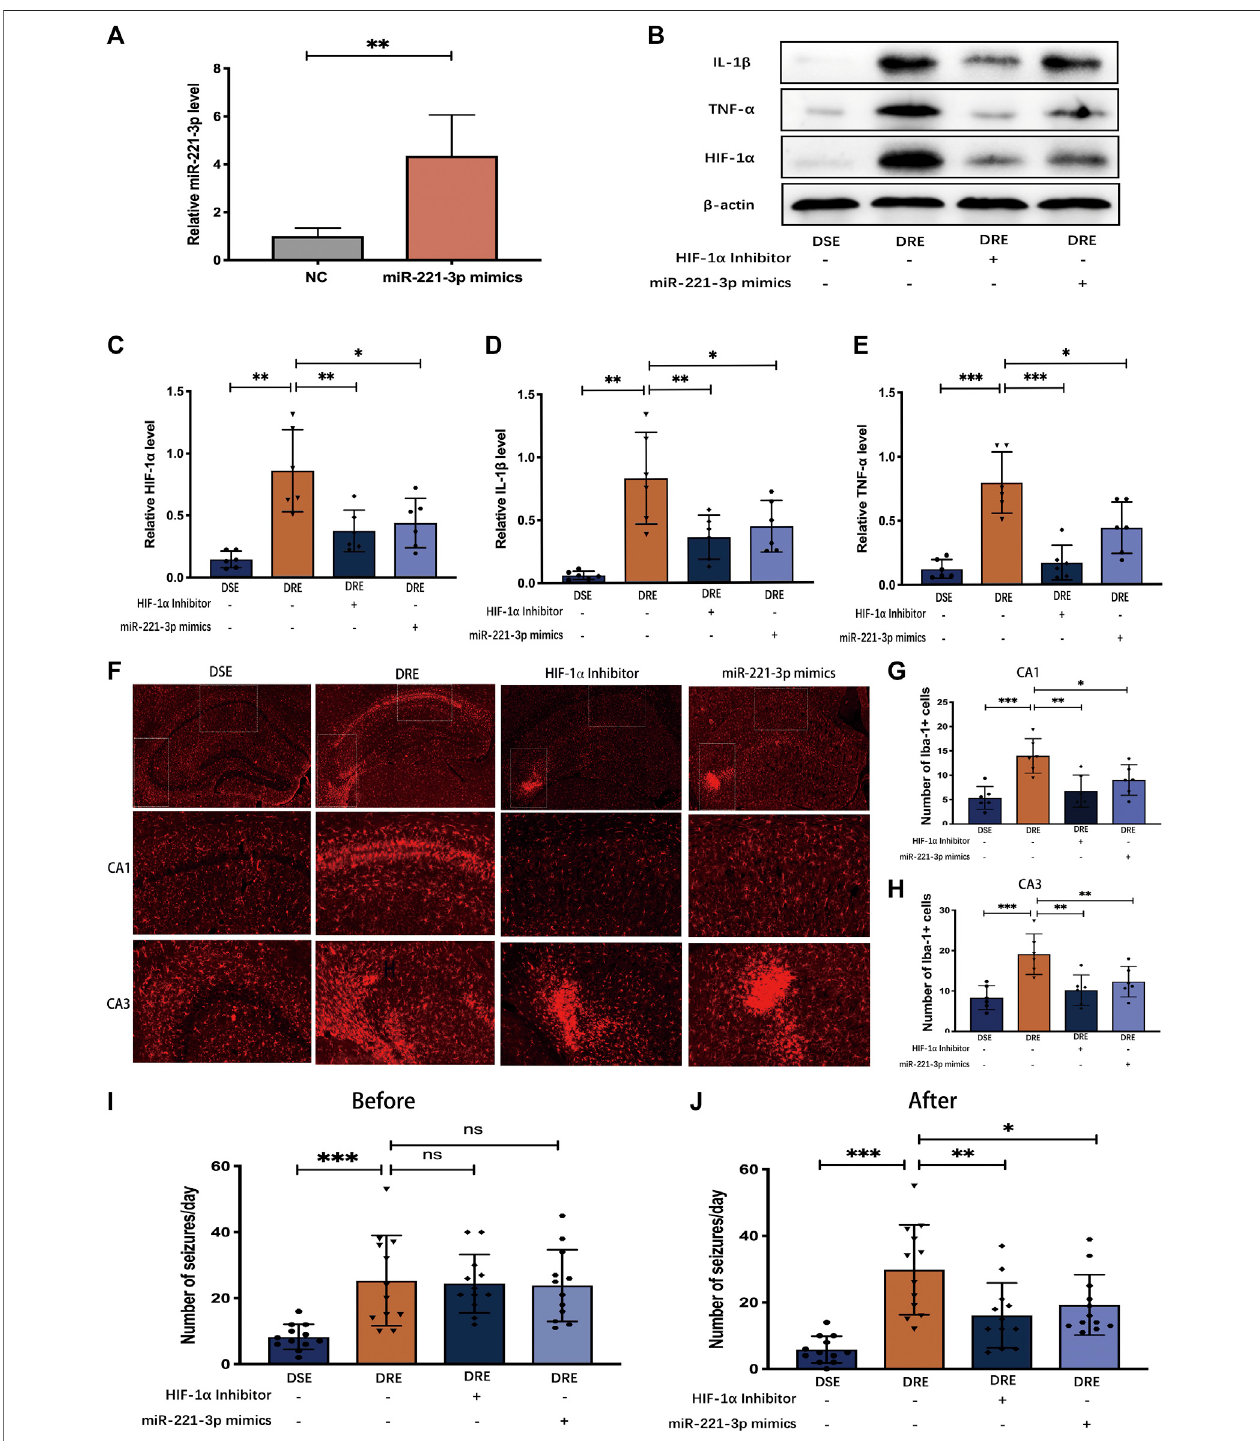
FIGURE7| EffectofmiR-221-3pmimicsandHIF-1 α inhibitorinmicewithVPA-resistantepilepsy( n (cid:1) 6). (A) MiR-221-3pmimicseffectivelyup-regulatedthelevelof miR-221-3pinhippocampusby4times.( B) RepresentativeproteinbandsofIL-1 β ,TNF- α ,andHIF-1 α asdeterminedbywesternblotting.MiR-221-3p mimics andHIF- 1 α inhibitor can signi fi cantly reduce the proteins expression of IL-1 β (C) TNF- α (D) and HIF-1 α (E) in the hippocampus of mice with VPA-resistant epilepsy. (F) Representative immunohistochemistry images of Iba-1 in the CA1 and CA3 region of hippocampus. MiR-221-3p mimics and HIF-1 α inhibitor evidently decreased the number of Iba-1-positive cells in the hippocampal CA1 (G) and CA3 (H) regions. (I) Before intervention with miR-221-3p mimics and HIF-1 α inhibitor, there were no obviousdifferenceinthenumberofseizuresbetweentheVPA-resistantgroupwiththemiR-221-3pmimicsorHIF-1 α inhibitorgroup. (J) MiR-221-3pmimicsandHIF-1 α inhibitorinhibitedthe seizure of VPA-resistant epilepsy. Values are the mean ± S.D. Unpaired t -test. * p < 0.05, ** p < 0.01, and *** p < 0.001. DSE: VPA-sensitive epilepsy and DRE: VPA-resistant epilepsy.